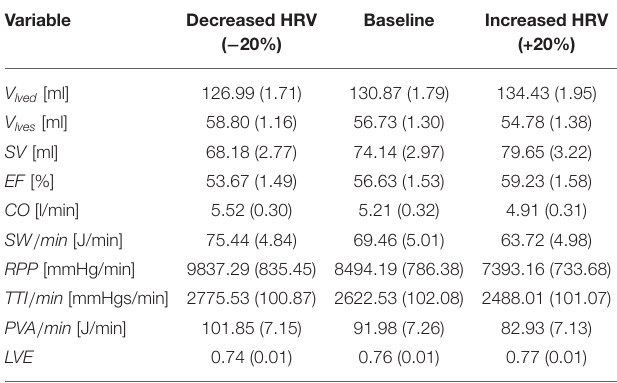
TABLE 4 | Cardiac parameters and oxygen consumption indexes at central level: mean